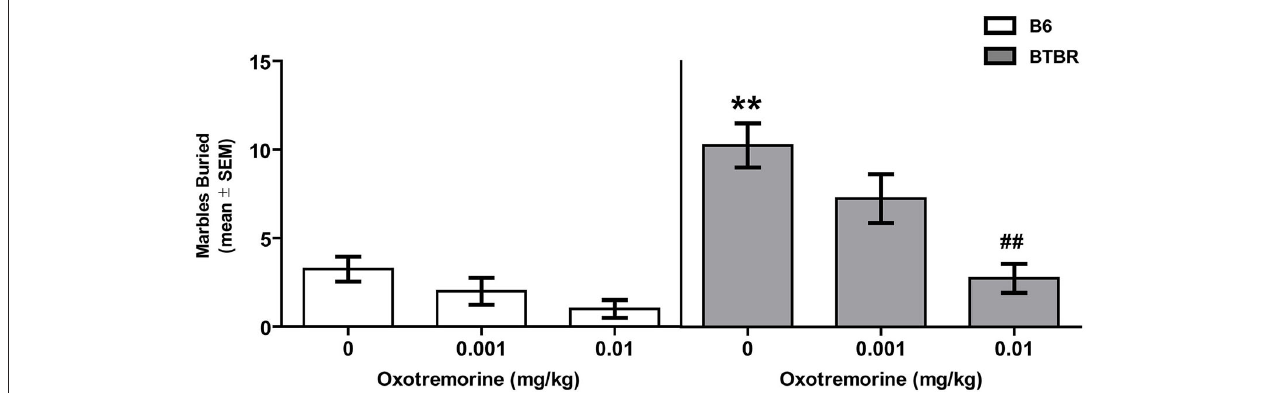
oxotremorine treatment did not significantly affect marble burying in B6 mice. Oxotremorine at 0.01 mg significantly decreased marble burying in BTBR mice. B6: vehicle ( n = 9), 0.001 oxo ( n = 8), 0.01 oxo ( n = 8), BTBR: vehicle ( n = 9), 0.001 oxo ( n = 9), 0.01 oxo ( n = 9). ** p < 0.01 vs. B6-vehicle, ## p < 0.01 vs. BTBR